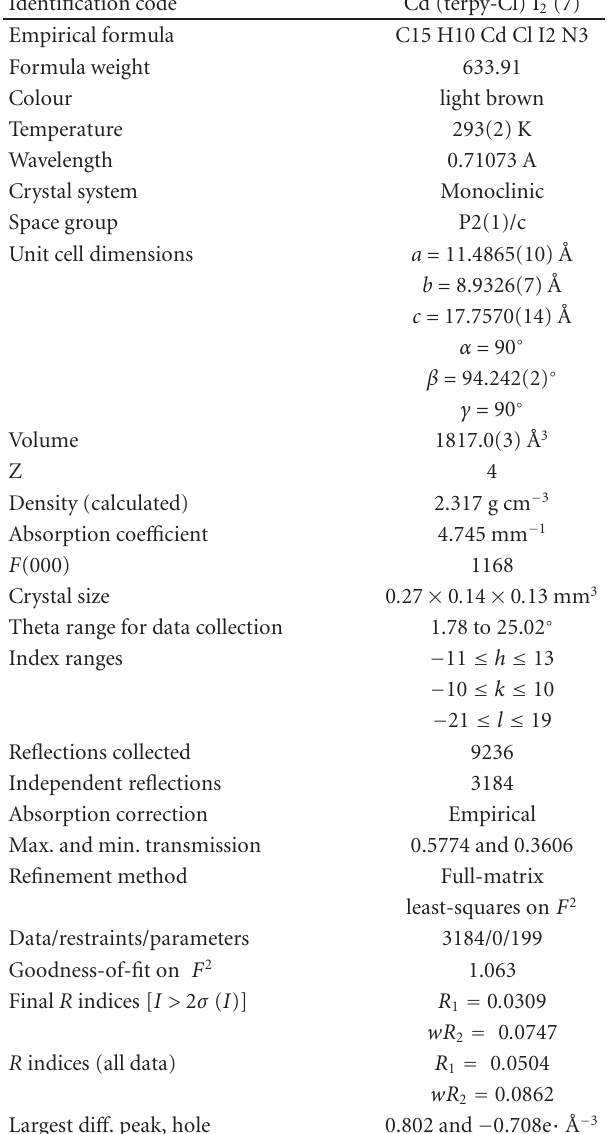
Table 1: Crystallographic data of [Cd(Cltpy)I 2